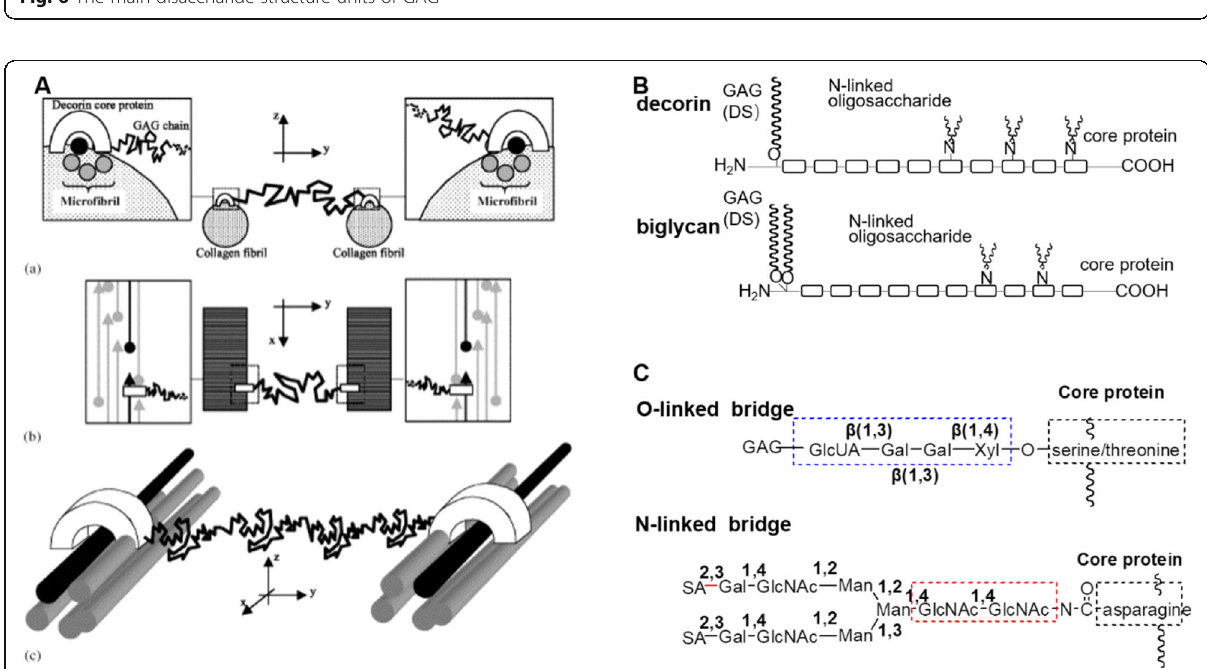
Fig. 6 The main disaccharide structure units of GAG